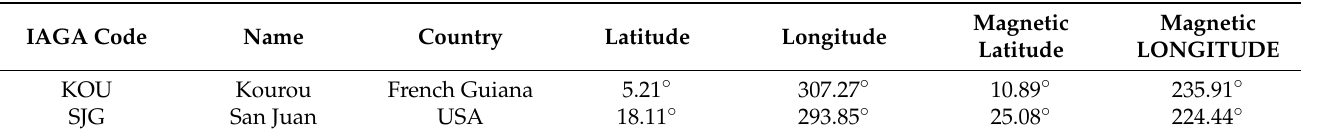
Table 1. The location, identifiers, geographic, and geomagnetic coordinates of the geomagnetic observatories used in this study.